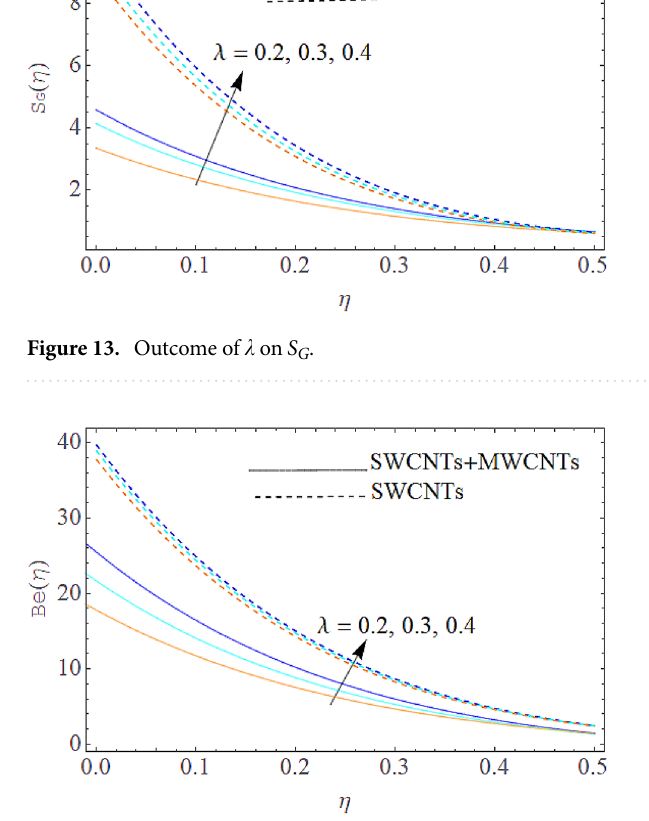
Figure 14. Influence of (cid:31) on Be .